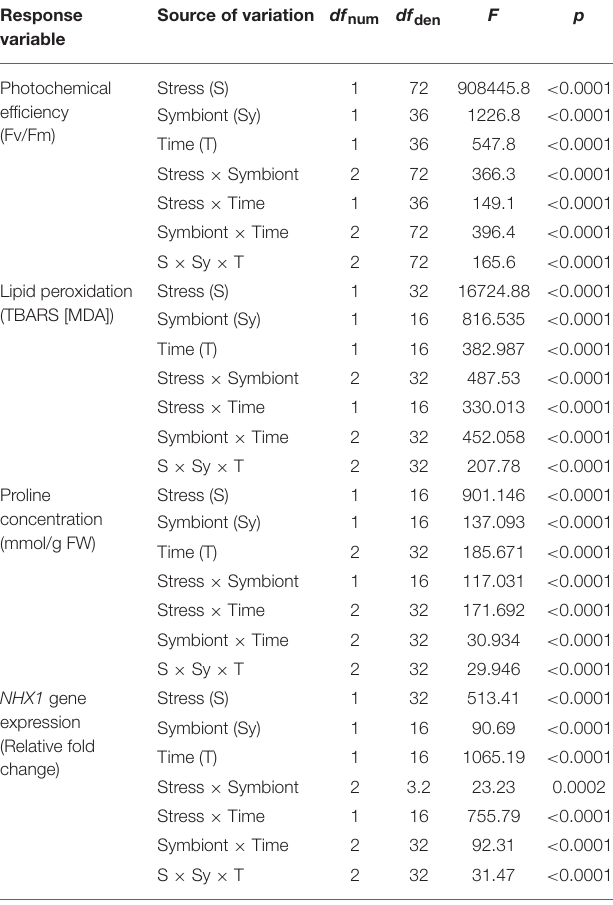
TABLE 1 | Repeated measures ANOVA for the effect of saline stress (S) and microbial symbiosis (Sy) on two variables of physiological performance ( a : photosynthetic efficiency; b : lipid peroxidation) and two specific stress-response mechanisms ( c : proline concentration; d : NHX1 relative expression).